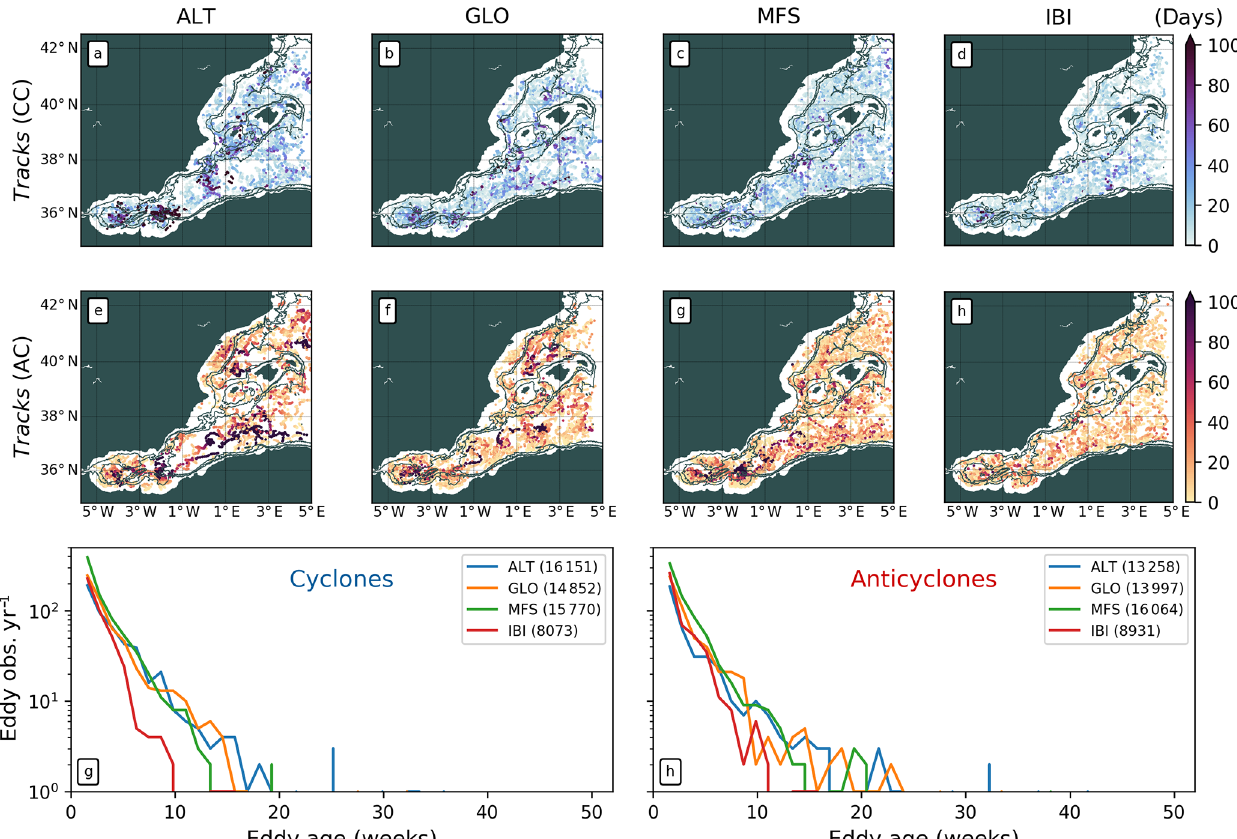
Figure 3. Scatter plots of (top row) cyclonic and (middle row) anticyclonic eddy observations in the western Mediterranean from altimetry and the three CMEMS models between 2013 and 2016. Colours indicate eddy age between 0 and 100 + d. Topographic contours from SRTM are plotted in gray at 500, 1000, 2000 and 4000m. Plots of eddy lifetimes of cyclones (bottom left) and anticyclones (bottom right) from altimetry and the three models are shown. Numbers in the legends show the total number of eddy observations for each